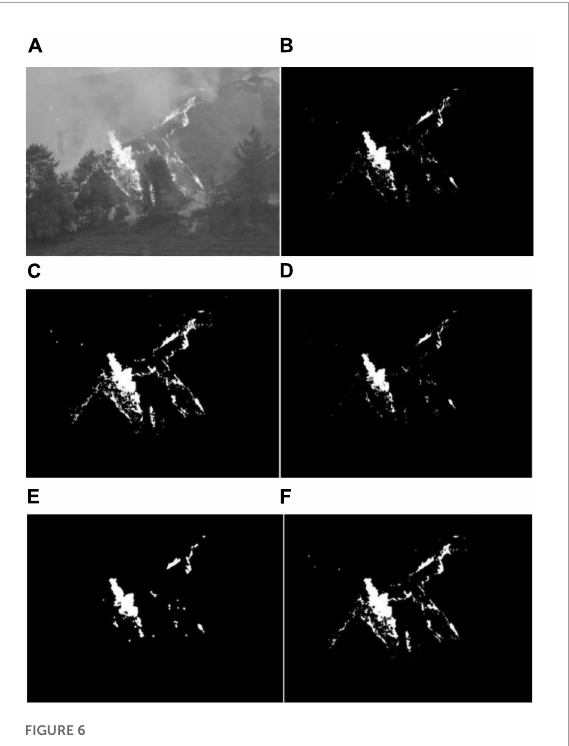
FIGURE6 Image morphological processing results: (A) Original image, (B) binarization treatment, (C) expansion treatment, (D) corrosion treatment, (E) open operation processing, and (F) closed operation